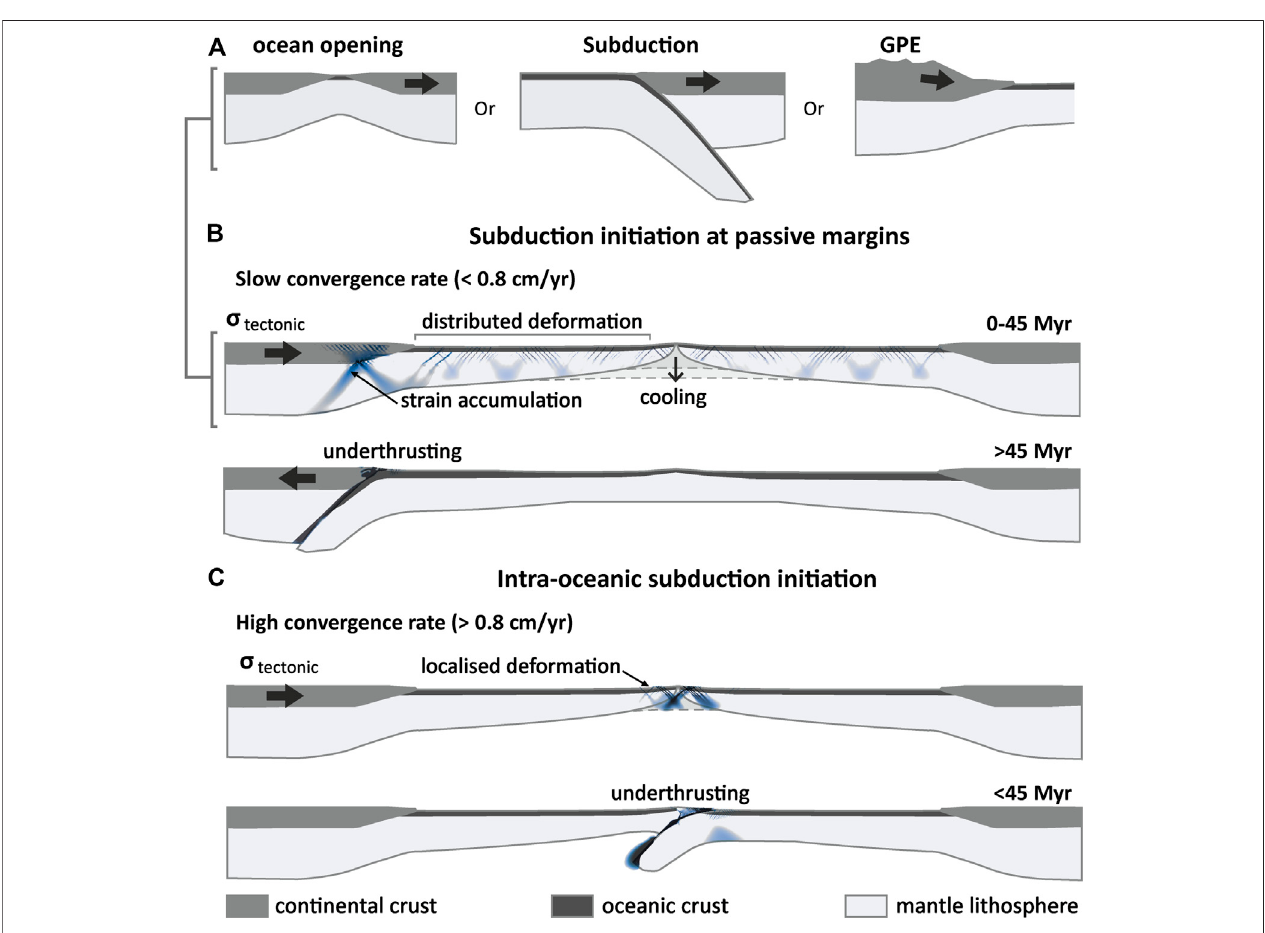
FIGURE8| Strain-ratedependentmechanismsforsubductioninitiationatpassivemargins. (A) Geodynamicprocessesthatpotentiallycontributetothetransferof stresstoapassivemargin. (B) Subductionatpassivemarginforslowlyconvergingocean-continentsystems:theformationofasubductionplateboundaryatthepassive margin critically depends on thestabilityofthe mid-oceanridge, which iscontrolled bythe distributed styleofdeformation. 0 – 45 Myr after the onsetofshortening: strain accumulation at passive margin under low convergence rate. > 45 Myr: strain localization and subduction. (C) Subduction amid oceanic plates for fast converging ocean-continent systems: Rapid closure of the oceanic basin leads to localized deformation and underthrusting near the ridge crest. Black arrows represent stress arising from mid-oceanic ridge and far- fi eld forcing.